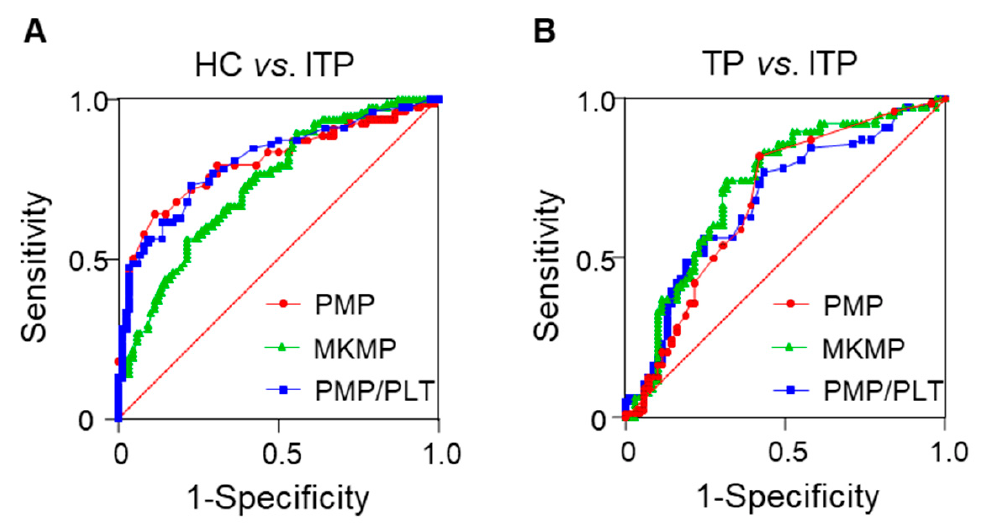
Figure 3. ROC analysis of plasma PMP and MKMP levels and PMP/PLT ratios for ITP diagnosis. ROC analysis was performed for PMP and MKMP levels and PMP/platelet count (PLT) ratios to evaluate their potential to distinguish ITP from healthy controls ( A ) and non-ITP patients ( B ). The AUC values were 0.805, 0.735 and 0.808 in ( A ) and 0.682, 0.723 and 0.681 in ( B ), respectively. AUC and cut-off values for PMPs, MKMPs, and PMP/PLT ratios to diagnose ITP and differentiate ITP from TP were listed in Table 2. Among them, PMP/PLT ratio had the highest diagnostic potential with 73.1% sensitivity and 77.3% specificity. In addition, MKMP levels at a threshold of 112.5 MPs/ µ L discriminated ITP from non-ITP with 74.4% sensitivity and 68.1% specificity (Table 2). Table 2. ROC analysis of plasma MP levels for ITP differential